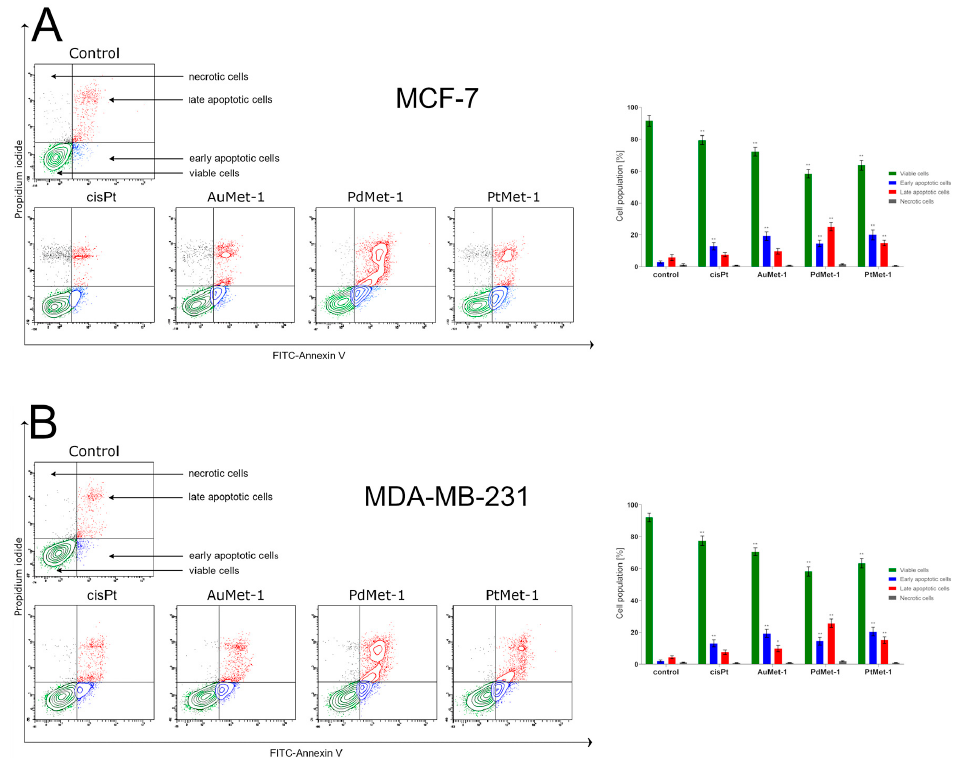
Figure 3. Flow cytometry analysis of MCF-7 ( A ) and MDA-MB-231 ( B ) breast cancer cells after 24-h